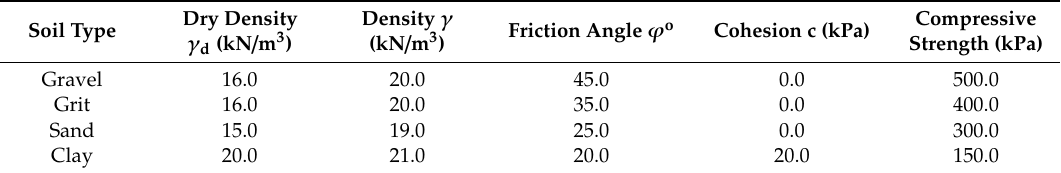
Table 1. Mechanical properties of soil